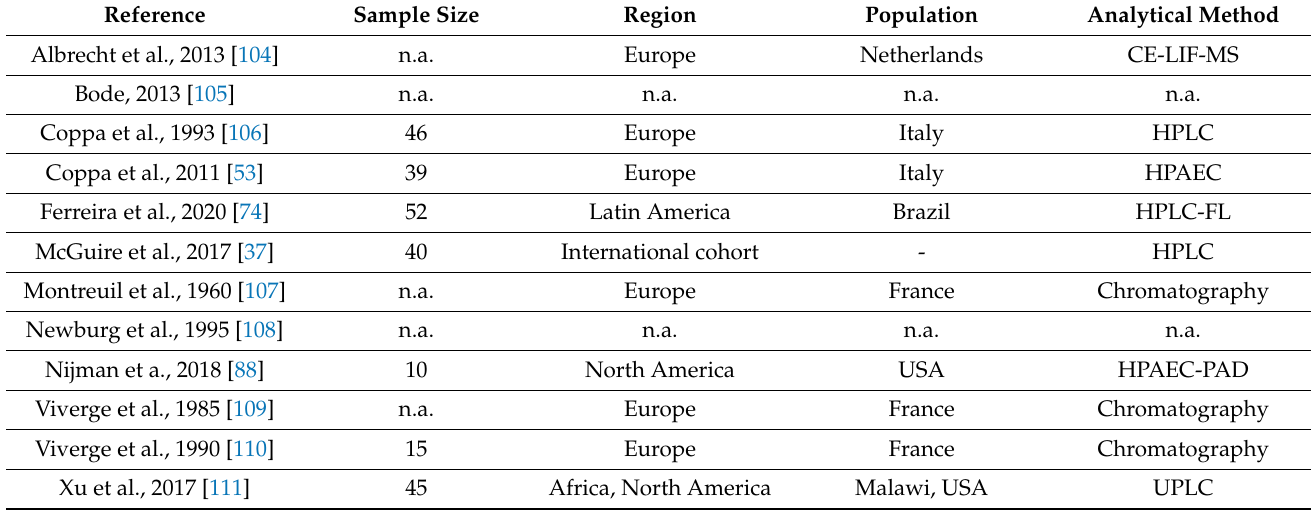
Table 7. Overview of the records reporting total HMO data were used to calculate the average total HMO fractions throughout lactation.